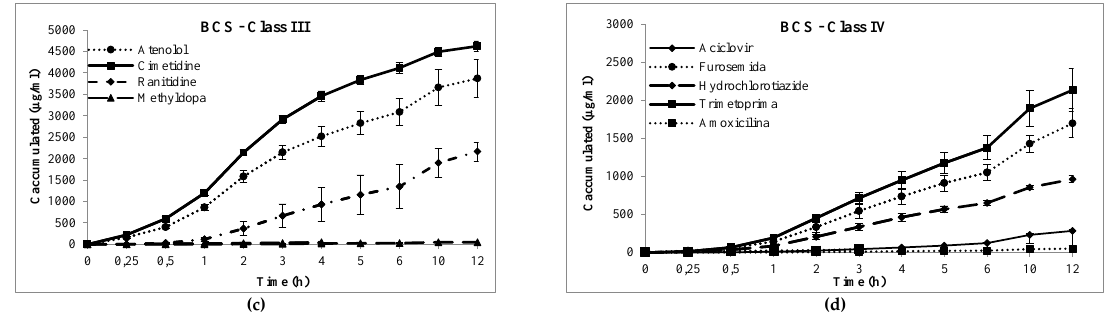
Figure 3. Cumulative transport ( µ g / mL, h) of drugs across Franz-PAMPA: ( a ) BCS class I; ( b ) BCS class II; ( c ) BCS class III; and ( d ) BCS class IV. Permeability was calculated from the linear portion (R 2 ). Data are presented as mean ± SD, n = 3